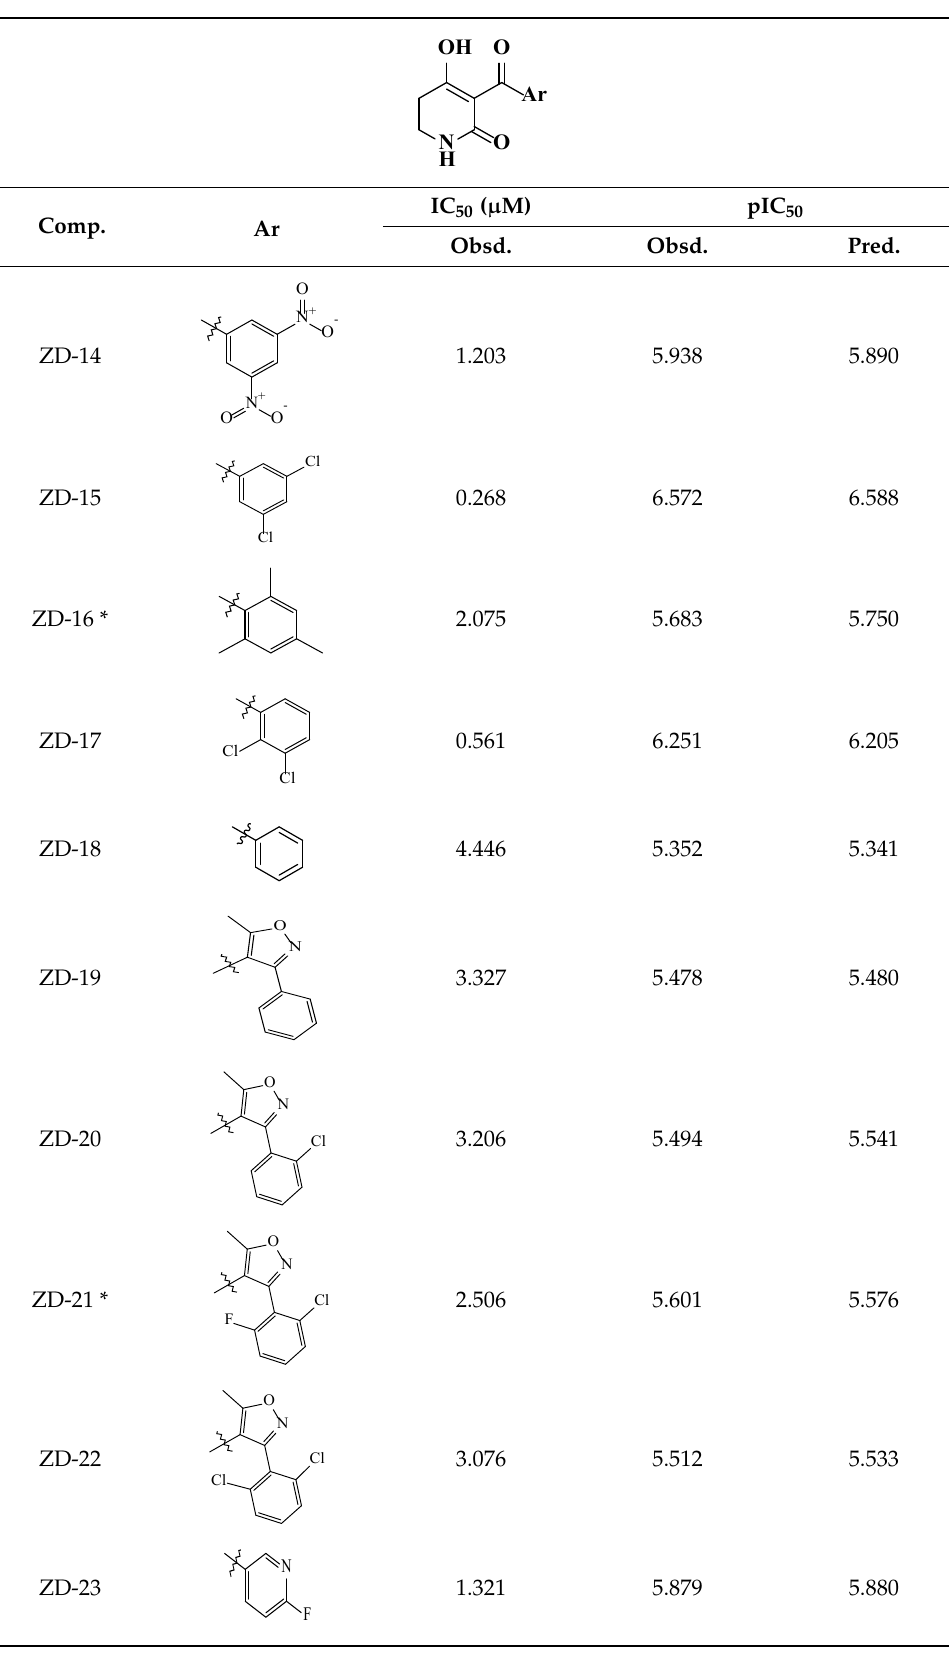
Table 7. Pyridine derivatives used for the Topomer CoMFA